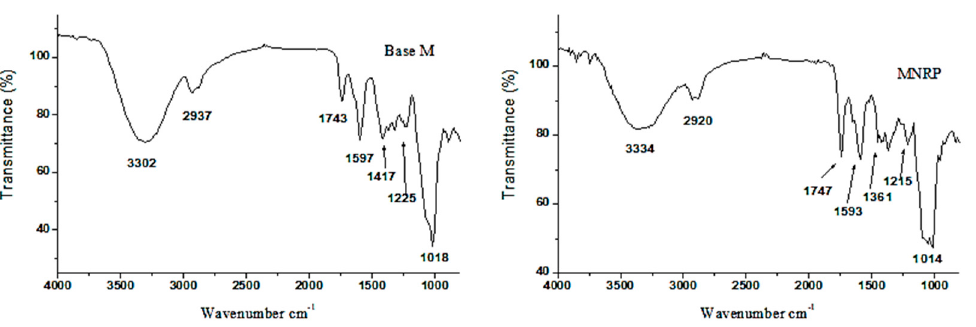
Figure 9. Attenuated total reflectance-Fourier transform infrared spectroscopy (ATR-FTIR) related to the Base M and MNPRP.